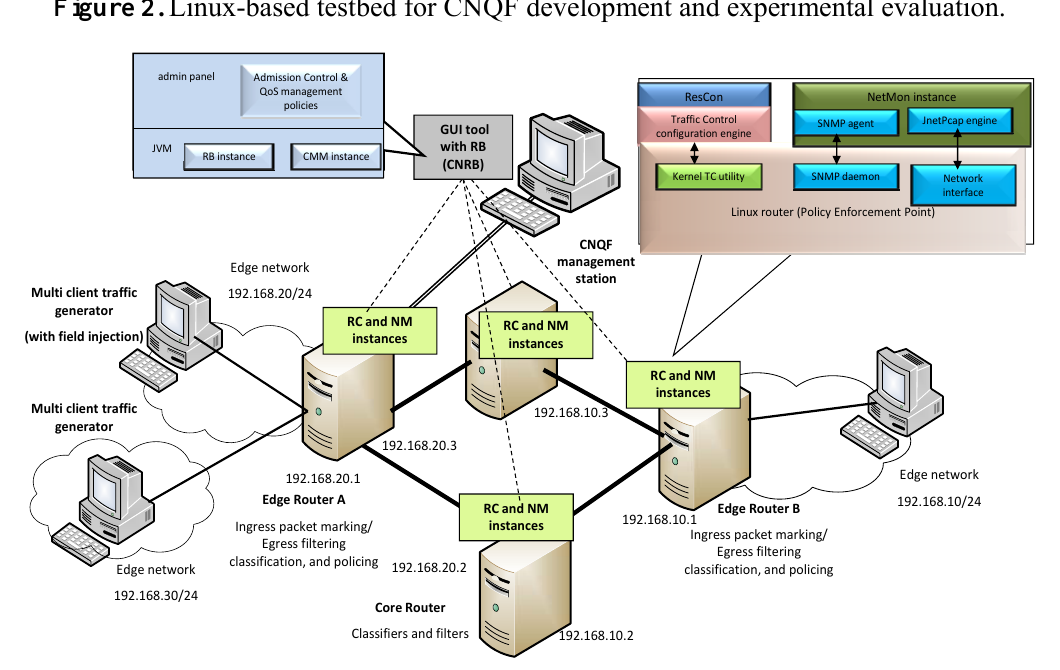
Figure 2. Linux-based testbed for CNQF development and experimental